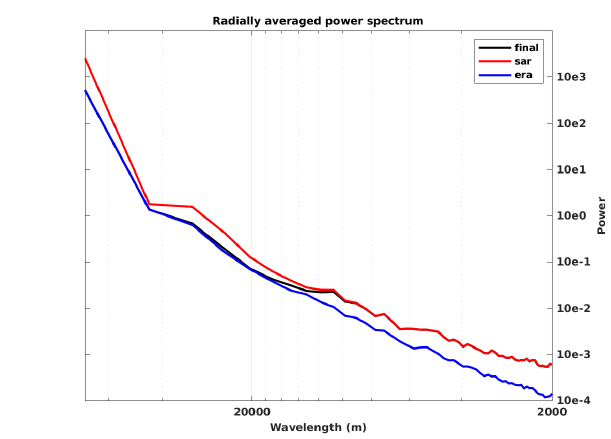
Figure 5. Radially averaged power spectra of meancorrected PSI, ERA5 and final